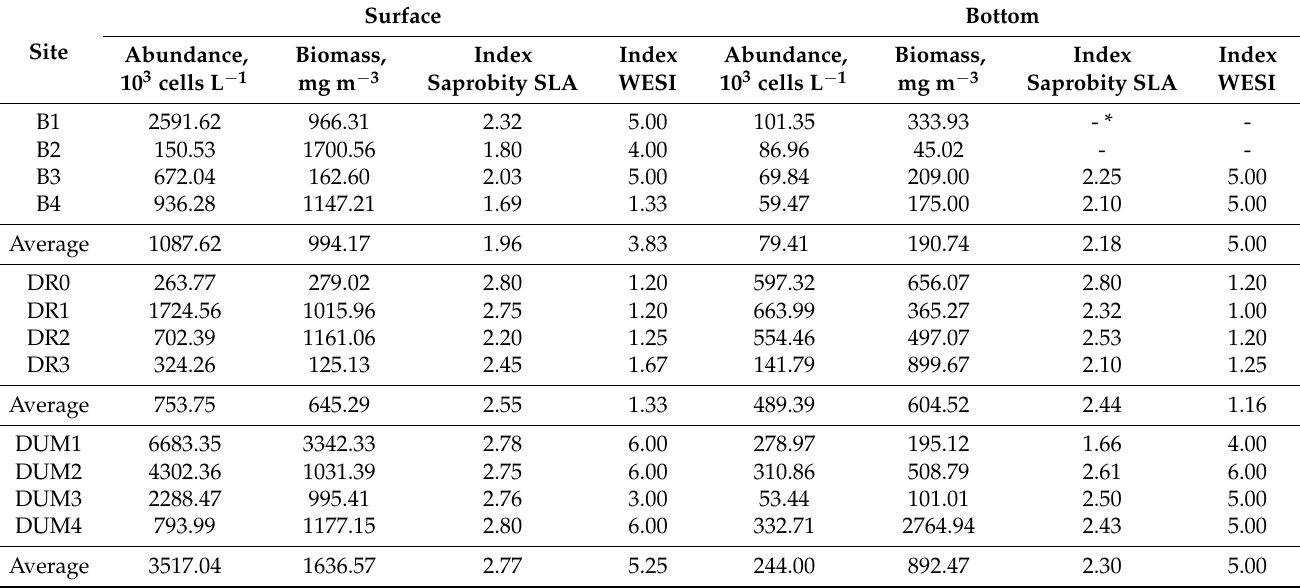
Table 4. Structural parameters of phytoplankton on two horizons in the Ukrainian part of the Danube nearshore area in August